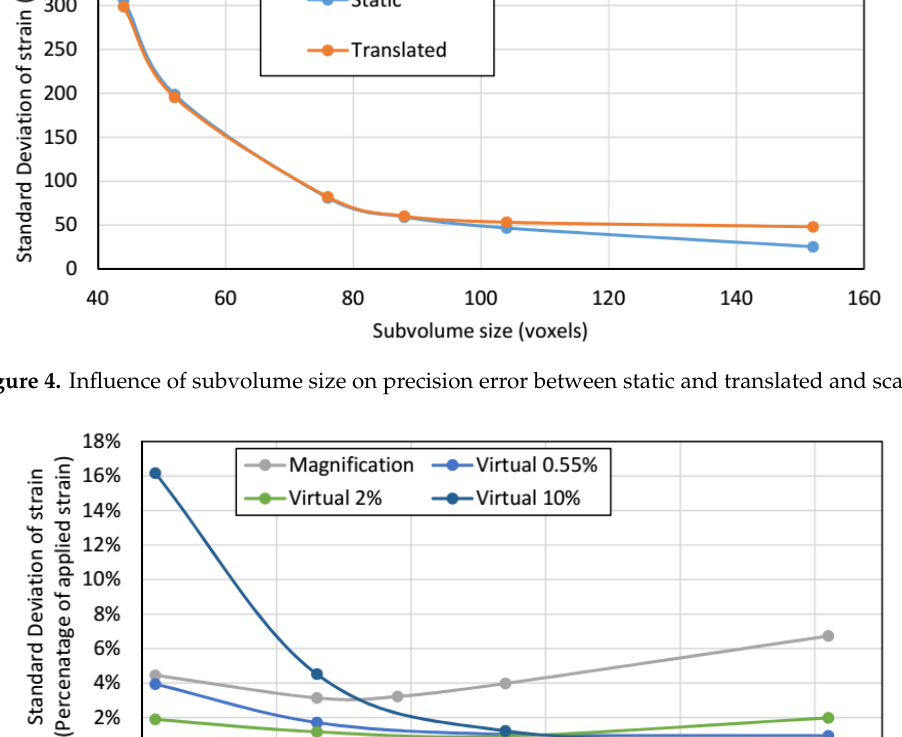
Figure 4. Influence of subvolume size on precision error between static and translated and scans. Strain accuracy (bias; mean strain) of static and translated scans was less than 10 με for all